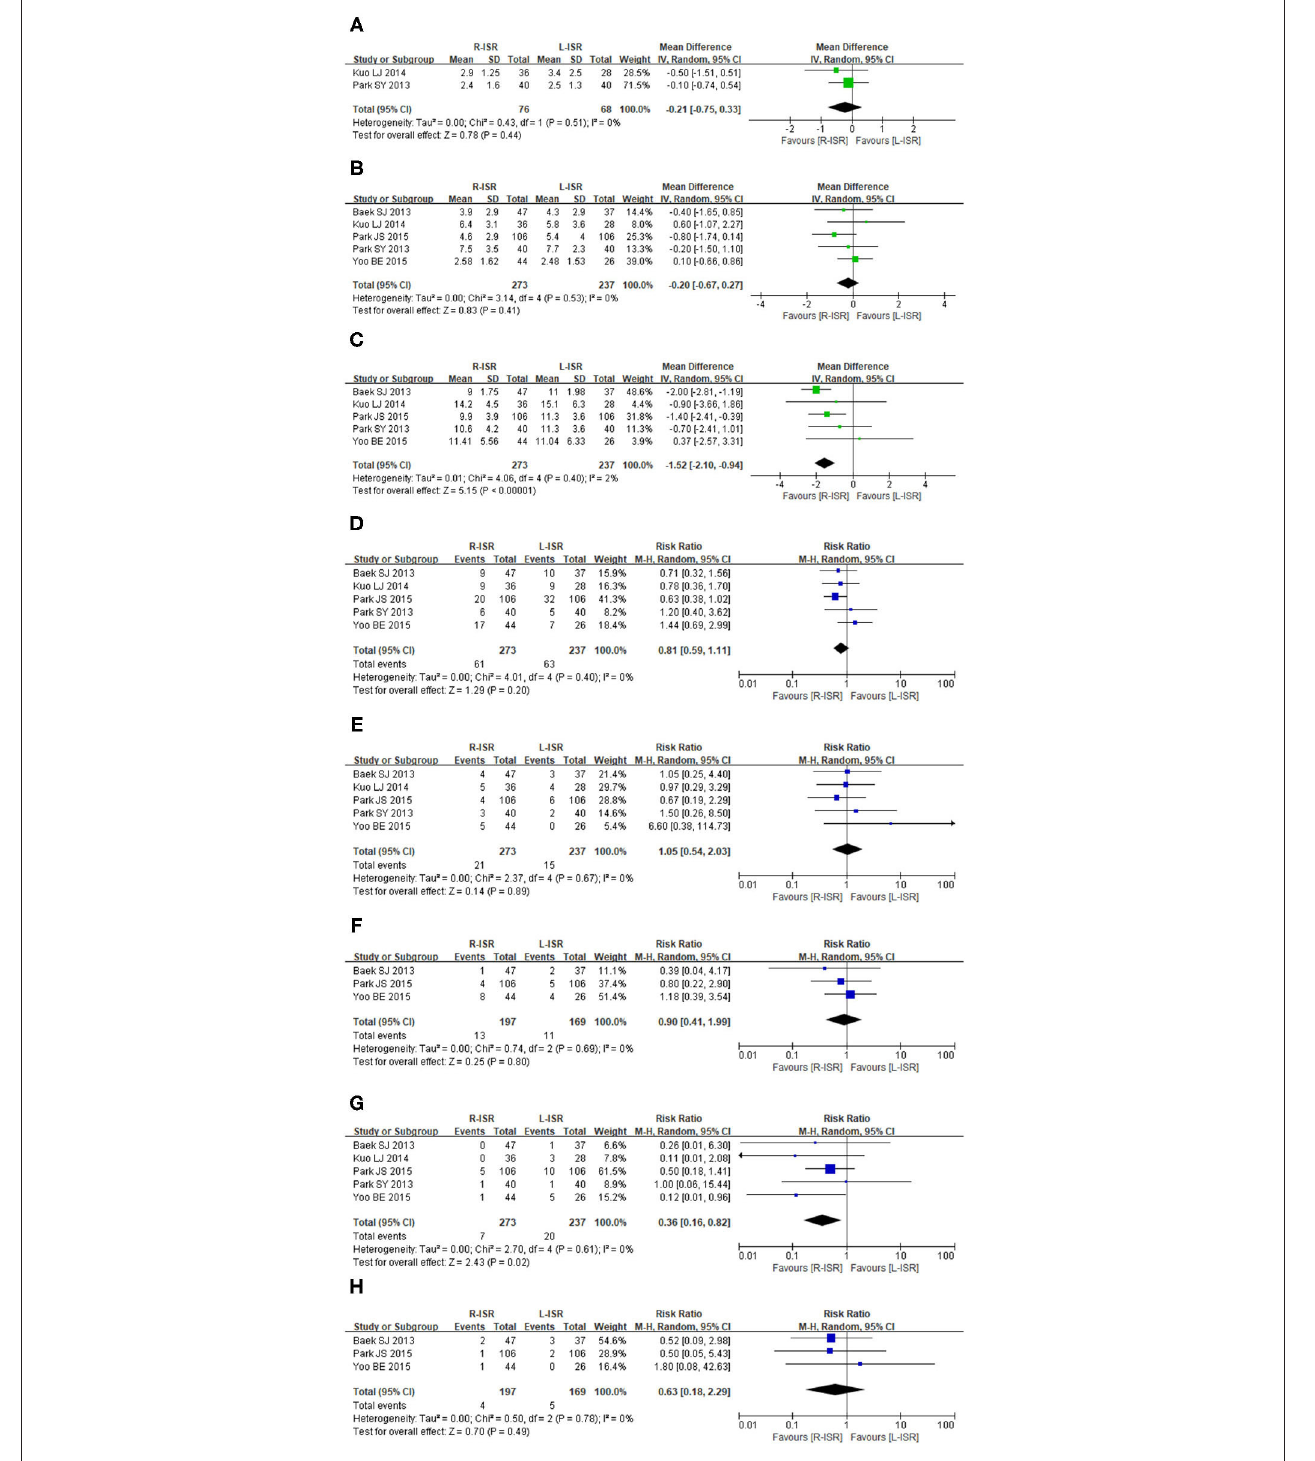
FIGURE 3 | Forest plots postoperative outcomes comparing time to first flatus (A) , time to resume regular diet (B) , duration of hospital stay (C) , postoperative complications (D) , anastomotic leakage (E) , postoperative ileus (F) , postoperative urinary complications (G) , intra-abdominal abscess (H) .